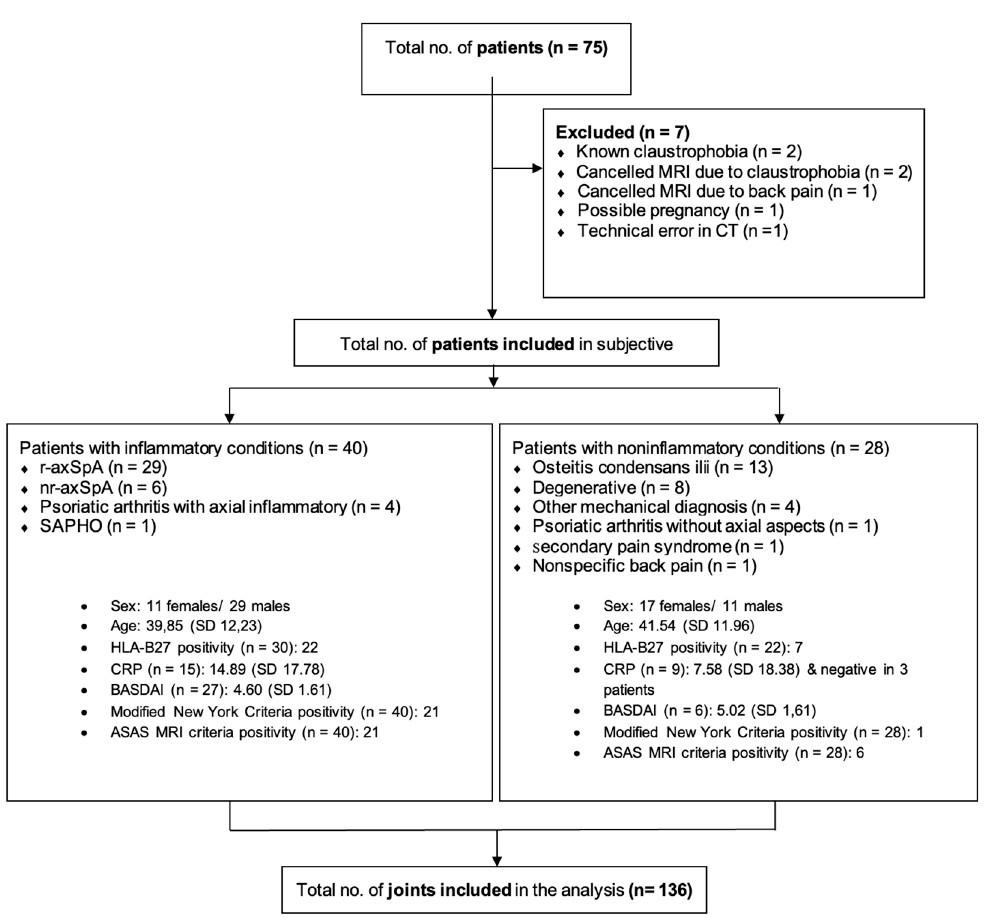
Figure 1. Flow chart of patient exclusion and characteristics of the final study population. A mixed study population of patients with inflammatory and noninflammatory diseases such as mechanical and degenerative diseases was investigated. A total of 35 patients were diagnosed with axial spondyloarthritis (axSpA). Final diagnoses were made by the treating rheumalogist. Females accounted for 41.2 % of the study population. Mean age was 40.54 years, and 27 patients were classified as positive according to the Assessment of SpondyloArthritis international Society (ASAS) definition of a positive MRI. r-axSpA, radiographic axial spondyloarthritis; nr-axSpA, nonradiographic axSpA; CRP, c-reactive protein; BASDAI, Bath Ankylosis Spondylitis Disease Activity Index. SAPHO, synovitis, acne, pustolisis, hyperostosis, and osteitis syndrome. 3.2. Imaging The mean DLP for all scans, including 41 total spine scans, was 118.03 mGy*cm with a mean estimated effective dose of 1.51 mSv for pelvic scans. The mean CTDI was 27.54 mGy. 3.3. Image Reading and Data Analysis 3.3.1. Osteitis Twenty-eight patients (30 joints) were scored as positive in MRI and 42 (56 joints) in DECT. Correlation of DECT with MRI was moderate on a per-patient level (r = 0.25, p = 0.04). Data on overall diagnostic accuracy and diagnostic accuracy for each reader are compiled in Table 1. Interrater reliability was poor for DECT (k = 0.19) and moderate for MRI (k = 0.56).